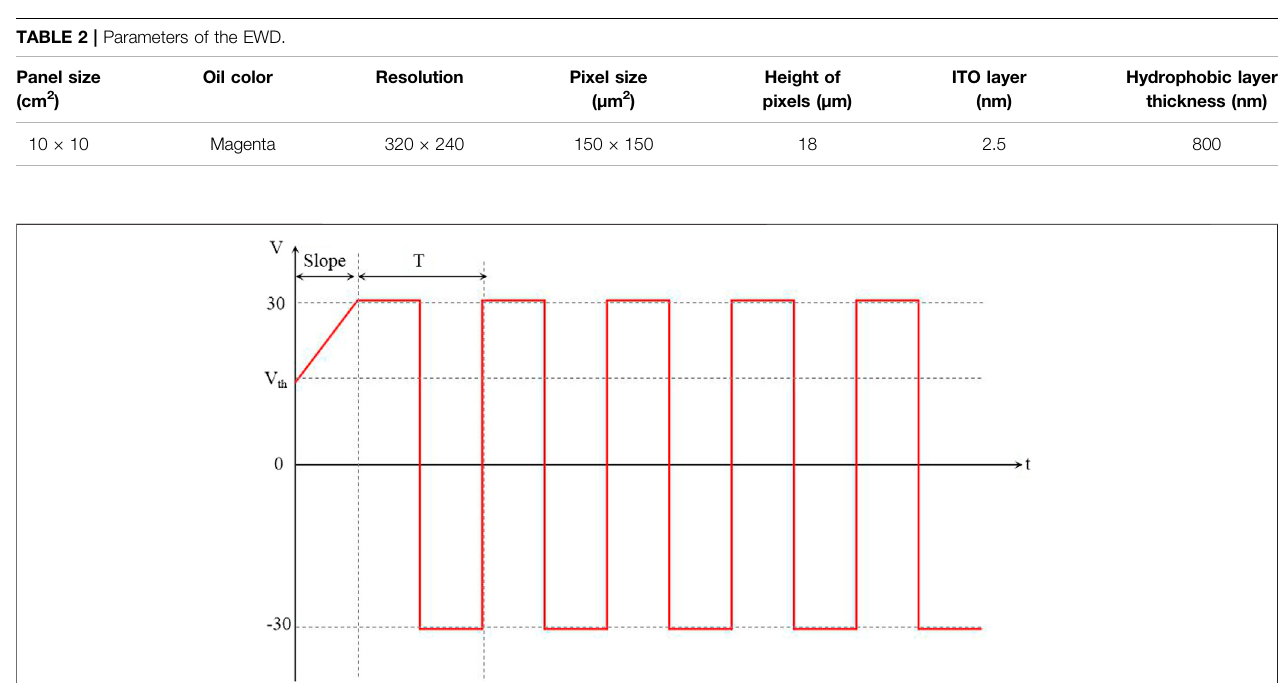
Frontiers in Physics |